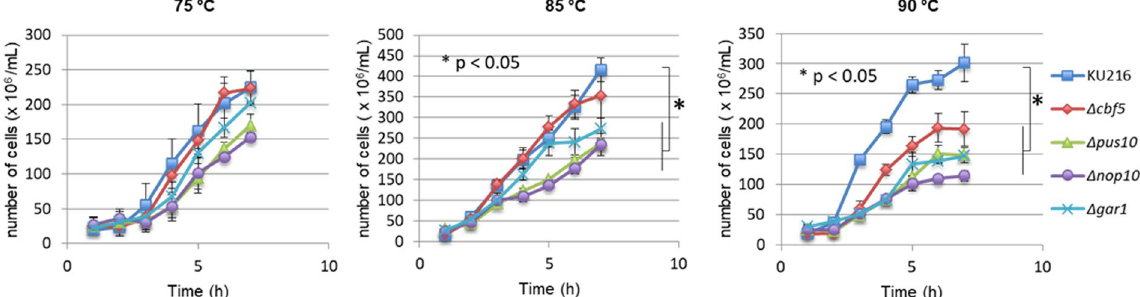
Figure 2. Analysis of the effect of gene disruption on cell growth. The various T . kodakarensis wild type (KU216) and mutant strains were grown in ASW-YT medium. Cultures were carried out at the optimal growth temperature of 85 °C, or at 75 °C and 90 °C, and cell growth was monitored by counting the number of cells with Thoma’s cell counter during the course of the culture. The mean values obtained from three independent experiments and the standard deviations are shown with bars. Significance values of * p < 0.05 relative to KU216. square: KU216, diamond: Δ cbf5 , triangle: Δ pus10 , circle: Δ nop10 , and cross: Δ gar1